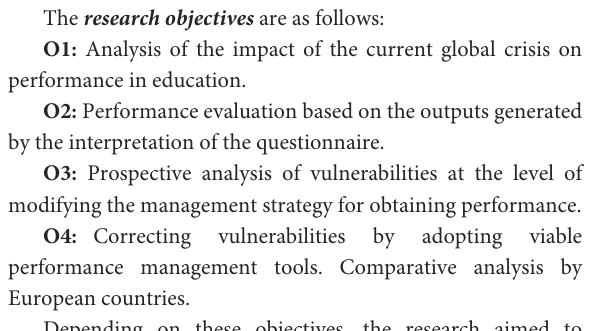
Figure 1 is based on a web of science platform search of 3,279 articles from 2018 to 2022, bibliometrically collected in common databases and designed as a bibliographic data network clustered by keyword groups using Visualizing Scientific